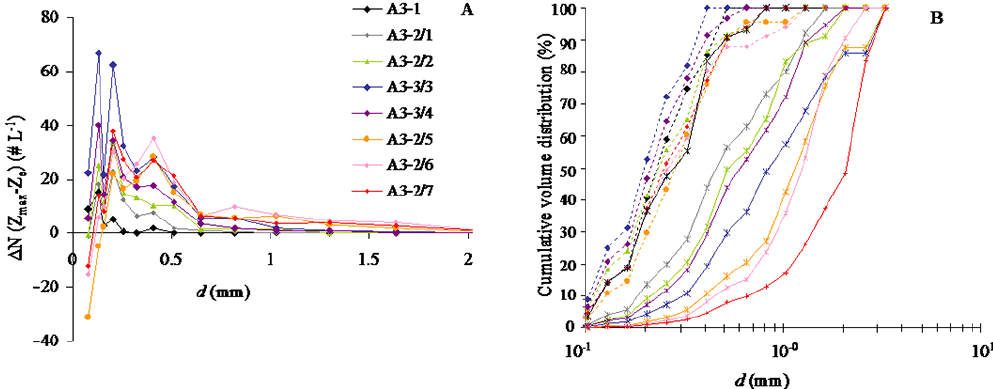
Figure 5. Difference of the size spectra abundance between the depth of the volume maxima ( Z max ) and the euphotic layer ( Z e ) (A) and cumulative volume distribution (B) in the euphotic layer (dashed line) and at the depth of the V T subsurface maxima (solid line).